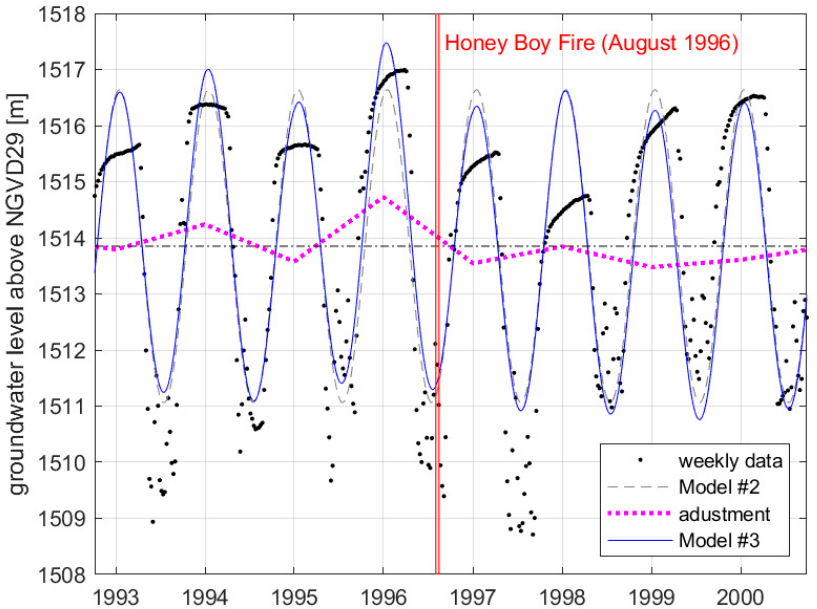
ual p , modeled as ∆ = Sp , where the slope S = 0.0025 m/mm.